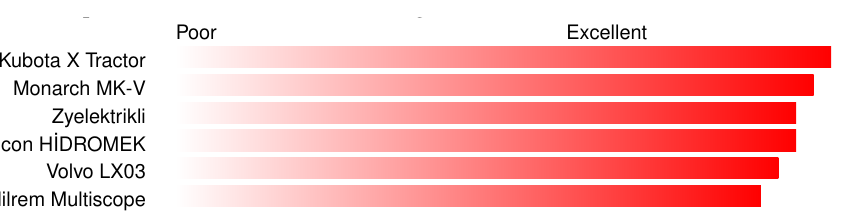
Figure 9. MIM overall evaluation: mobility and power KPIs